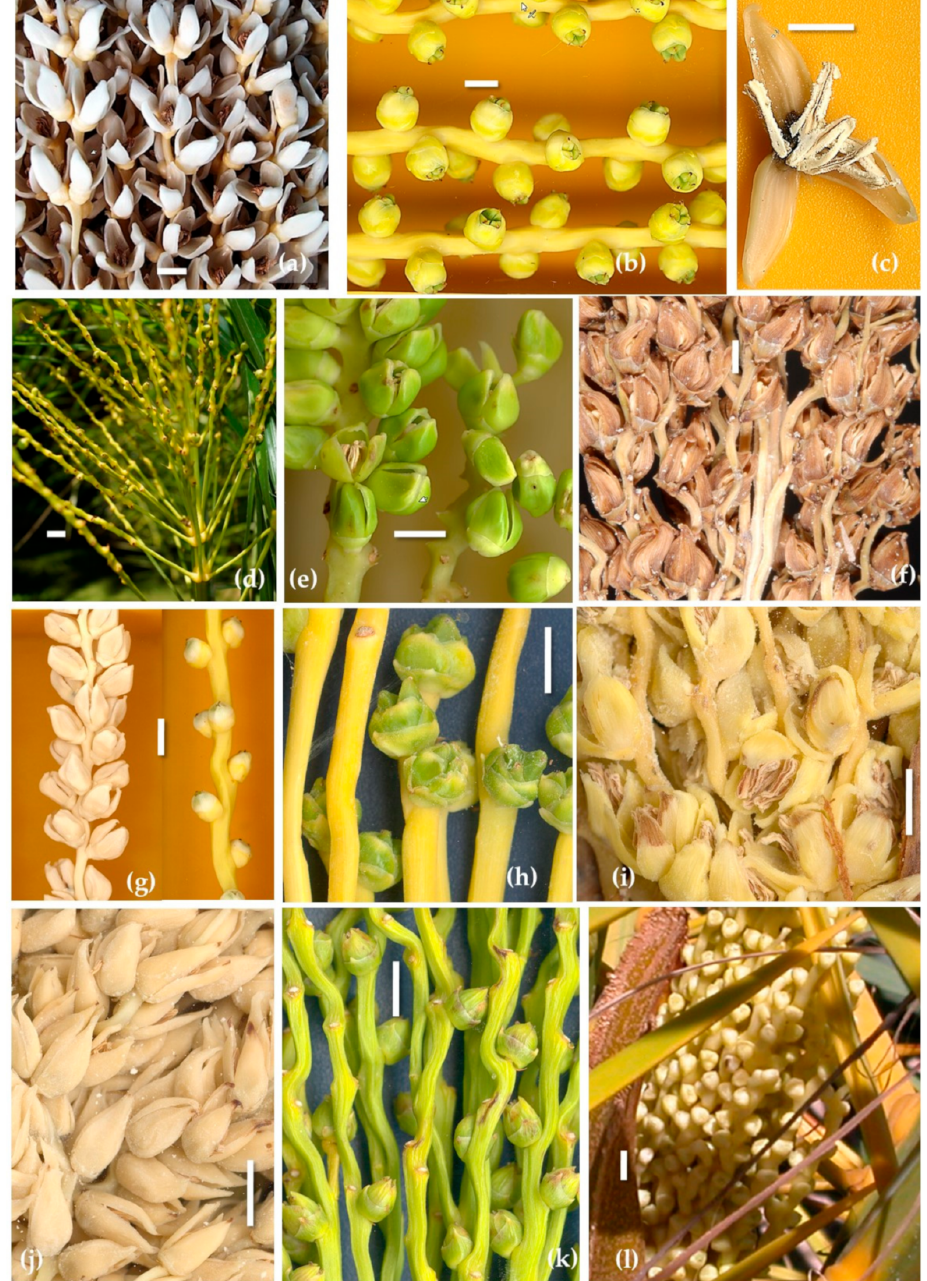
Figure 3. Diversity of Phoenix: flowers. ( a ), P. dactylifera “Candits” Male Western Group (W_DAC) (Elche, Spain); ( b ), P. dactylifera “Candits” Female (Elche, Spain); ( c ), P. dactylifera var. costata Male Western Group (W_DAC) (Santomera, Spain); ( d ), P. loureiroi var. pedunculata Female (Huerto del Cura, Elche, Spain); ( e ) P. loureiroi var. loureiroi Male (Orihuela, Spain); ( f ), P. arabica Male (Djebel Bura, Yemen); ( g ), P. canariensis var. canariensis (San Pedro, Spain) Male and Female; ( h ), P. iberica Female (Abanilla, Spain); ( i ), P. iberica Male (Abanilla, Spain); ( j ), P. roebelenii Male (Orihuela, Spain); ( k ), P. roebelenii Female (Orihuela, Spain); ( l ), Phoenix theophrasti Female (Palmasur, Alicante, Spain). Abbreviations for the major P. dactylifera geographical groups: W_DAC: North Africa and Mediterranean P. dactylifera. Scale bar: 5 mm. Images: ( a – l ). Diego Rivera and Concepci ó n Ob ó